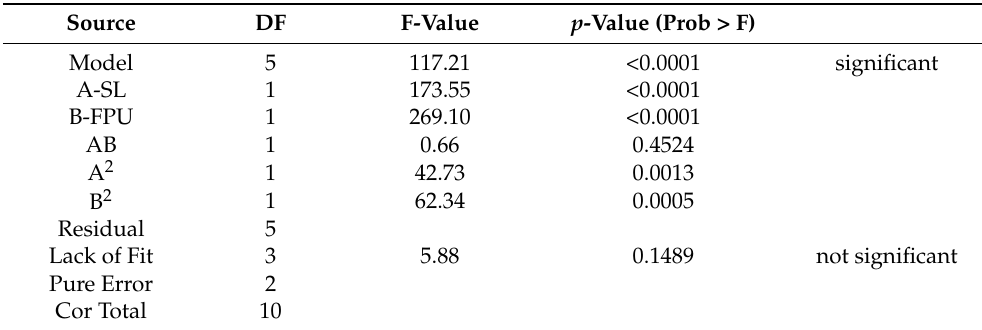
Table 4. ANOVA of the model-predicted glucose yield from biomass hydrolysis. Degree of Free- dom